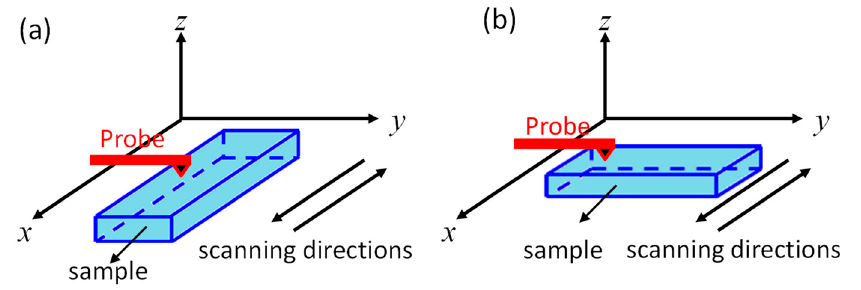
Figure 1. Schematic diagram of the sample orientation and scanning directions: ( a ) before 90° rotation and ( b ) after 90° rotation.